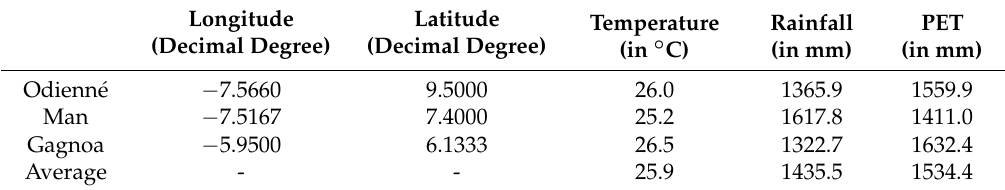
Figure 2. Rainfall and temperature monthly averages over 30 years (1961–1990). Table 1. Rainfall and temperature annual averages over 30 years (1961–1990).